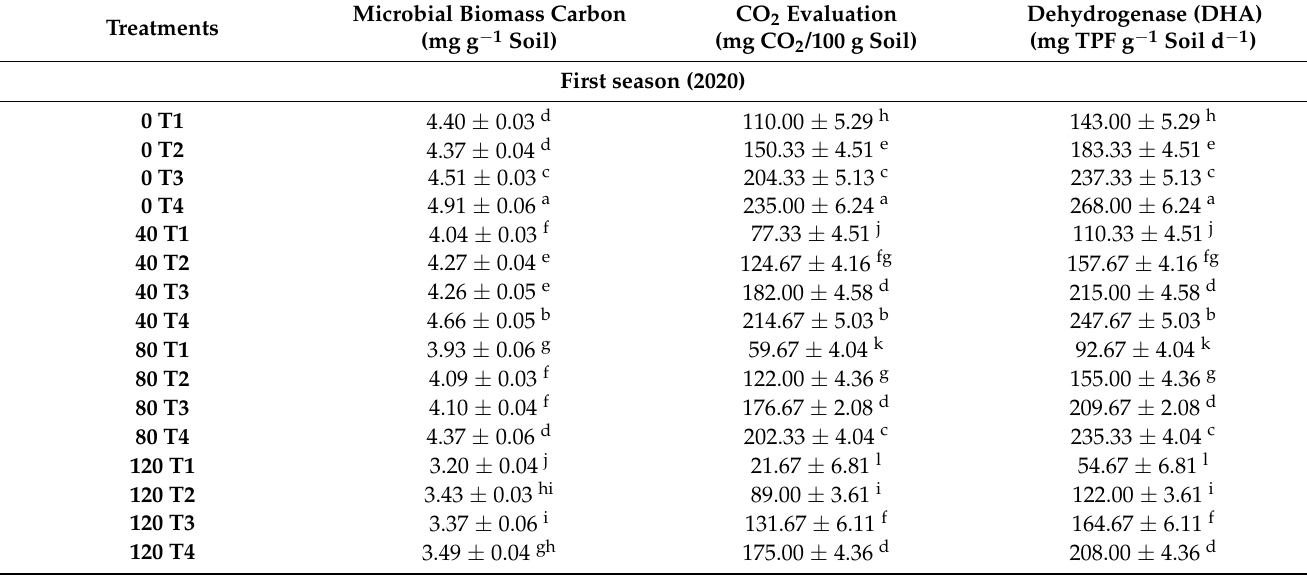
Table 3. Combined effects of different concentrations of Cd and soil amendments on microbial biomass carbon, CO 2 evaluation, and dehydrogenase of lettuce leaves 30 days after transplanting during the 2020 and 2021 seasons.